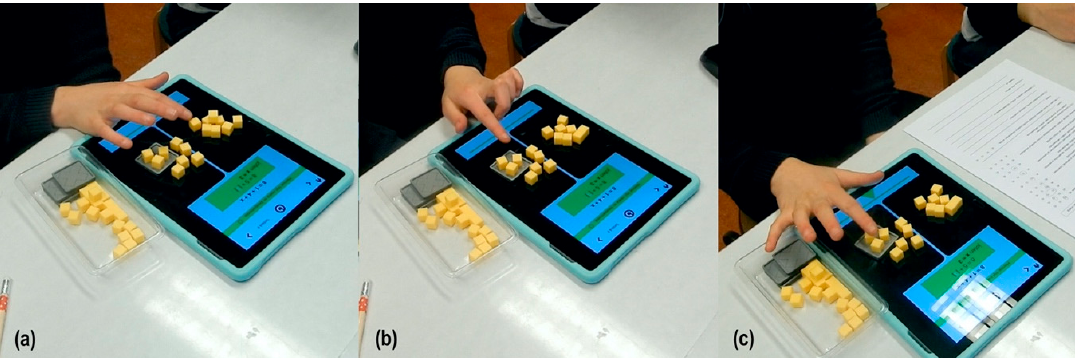
Figure 10. Student solving an equation (8 = 1 + 4 + x) at Level 1 (reasoning for the unknown). ( a ) ‘Here are eight’ (pointing at eight base-10 units on the left side of the scale); ( b ) ‘And here has to weigh the same’ (pointing at the right side of the scale); ( c ) ‘You have to add [base-10 units] here, so that they [units on the right side] are altogether eight’ (pointing at three base-10 units inside the X-Box on the